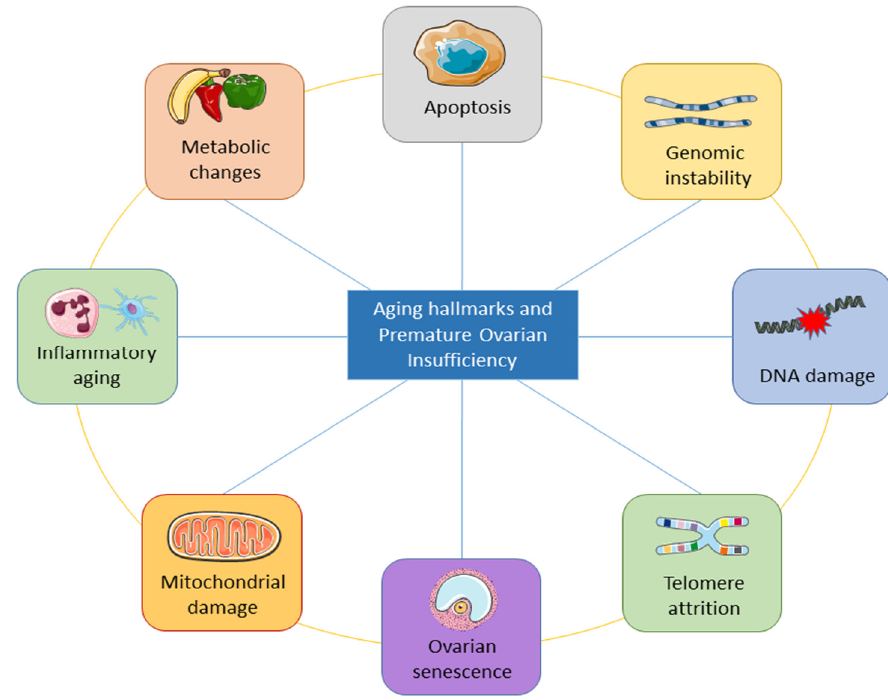
Figure 3. Important aging hallmarks of premature ovarian insufficiency. Inflammatory aging, apoptosis, DNA damage, genomic instability, ovarian senescence, telomere attrition, mitochondrial dysfunction, and metabolic changes seen in POI.